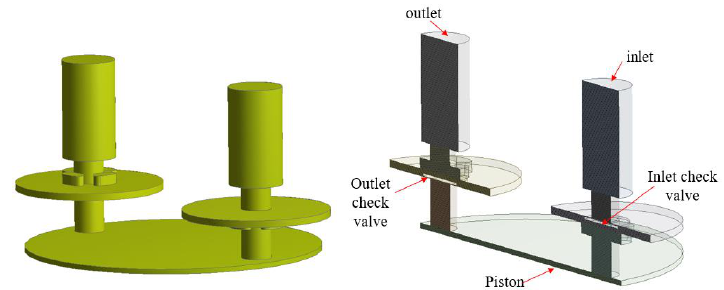
Figure 4. The fluid domain inside the piezoelectric-hydraulic pump. The grid simulation is defined as a trimmed mesher (predominantly hexahedral mesh), and the refinement of the boundary layer is defined as a prism layer mesher. Local grid refinement is conducted in the area near the check valve where the internal flow field is more complicated. In other words, refinement mesh is applied in areas near the movement zone of the check valve, and the piston where velocity gradients are predicted. A finer mesh tool is applied, with the size of the mesh at that zone being 0.025 mm. The grid quality is checked thoroughly. The refinement mesh of the important region is shown in Figure 5.